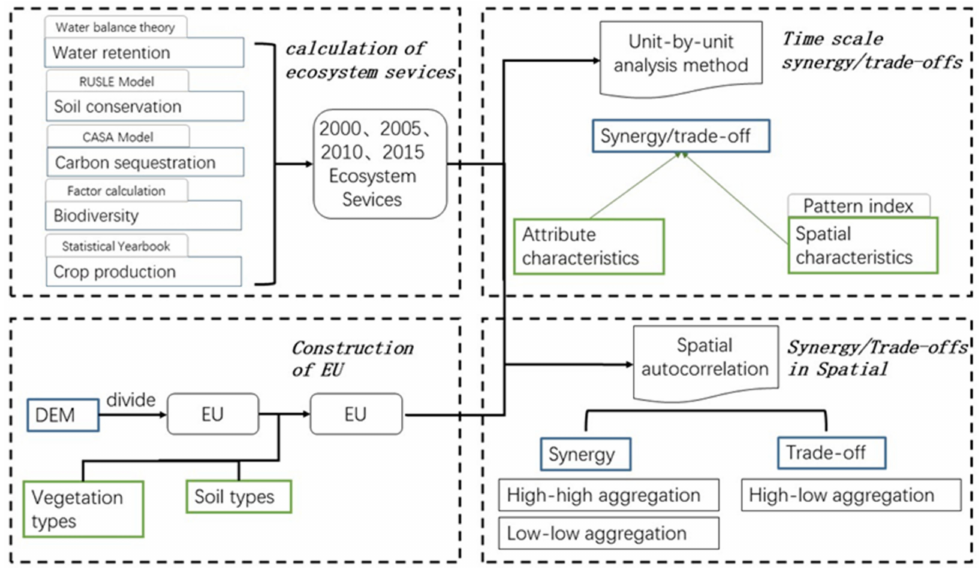
Figure 2. The research framework of the ecosystem services